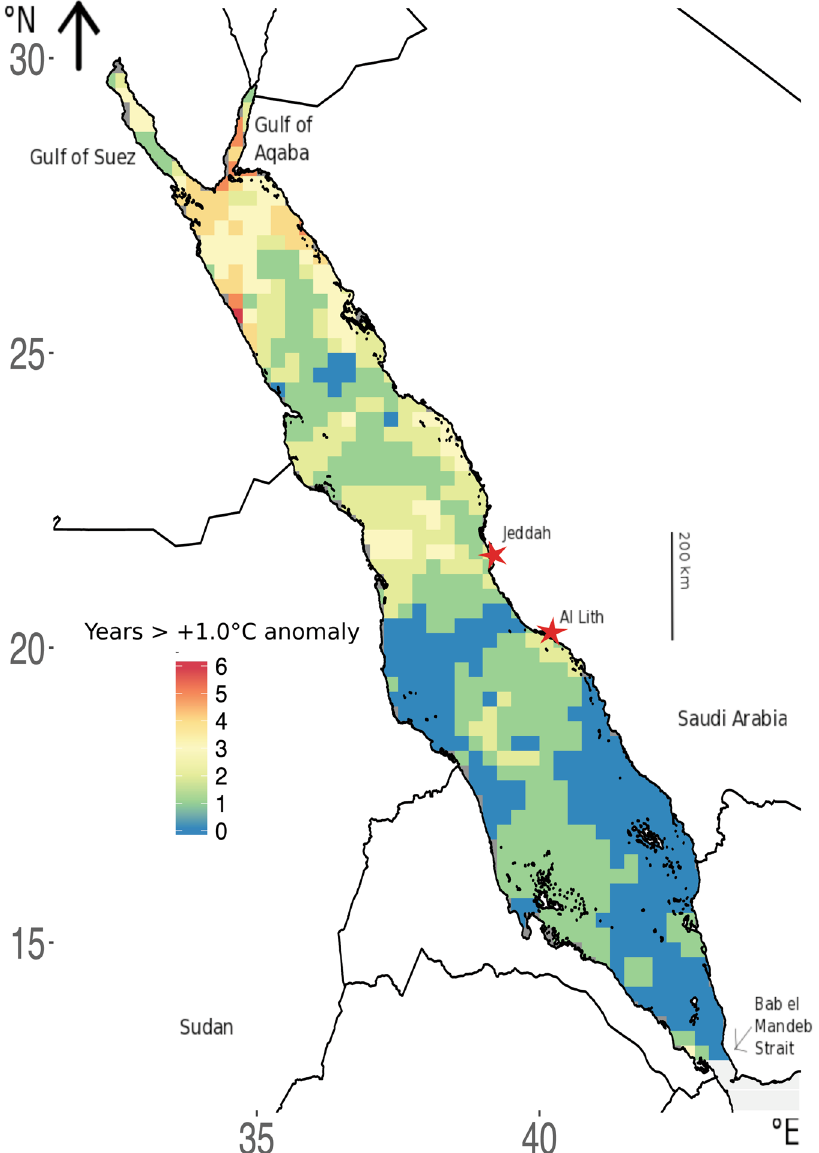
Figure 4. Distribution of the frequency, as number of years, across the Red Sea when maximum annual temperature (T max ) reached 1.0 °C higher than the mean T max for 1982–2015. Image created using R (v3.3.1, www.R-project.org) 45 including packages: ggplot2 46 and rasterVis 47 , RStudio (v1.0.143, www.rstudio.com), and InkScape (v0.91,